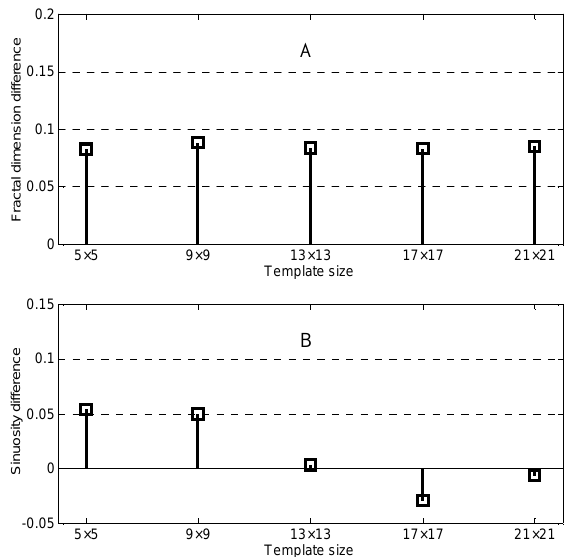
Figure 5. Difference of fractal dimension (A) and sinuosity (B) between the extracted and the reference